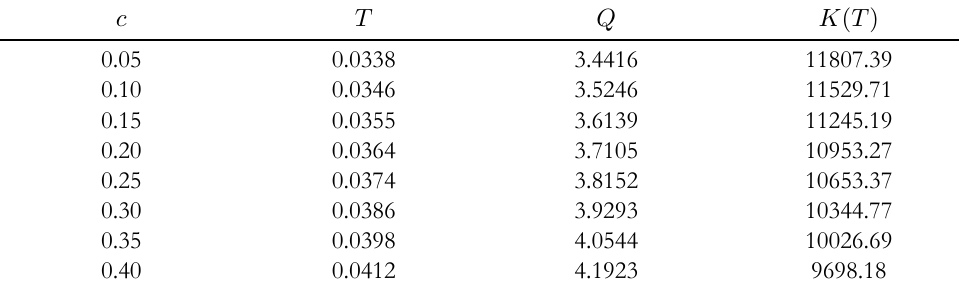
Table 4: Variation in T; Q & K ( T ) with coefficient (c)